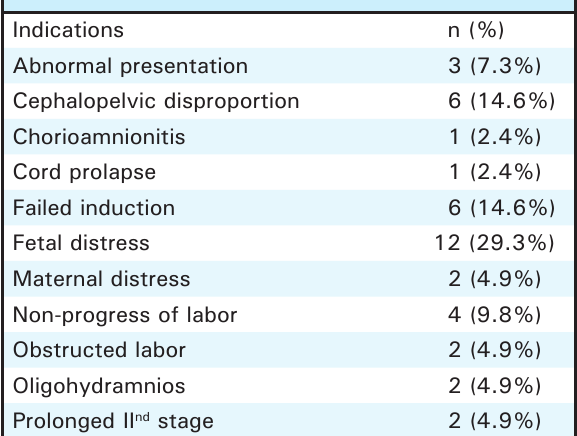
Table 2. Indications of caesarean section.